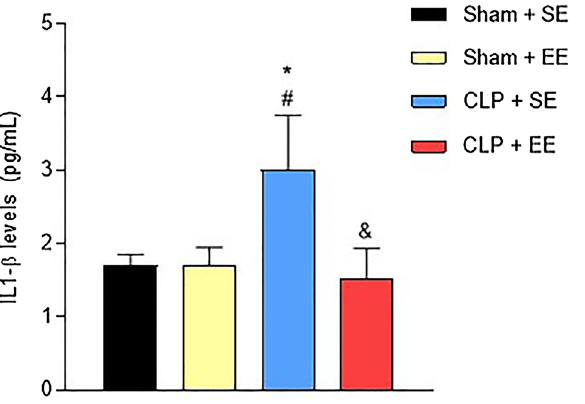
Figure 9. IL-1β levels in the hippocampus after the environmental enrichment protocol in animals submitted to sepsis. IL-1β levels were measured at the end of the environmental enrichment protocol in the hippocampus of animals subjected to sepsis. The data were expressed as mean ± SD and compared with one-way analysis of variance (ANOVA) followed by the Tukey test. nº = 6 each group. * p < 0.05 different from sham + SE; # p < 0.05 other than sham + EE; & p < 0.05 other than CLP + SE. EE: environmental enrichment; SE: standard environment.